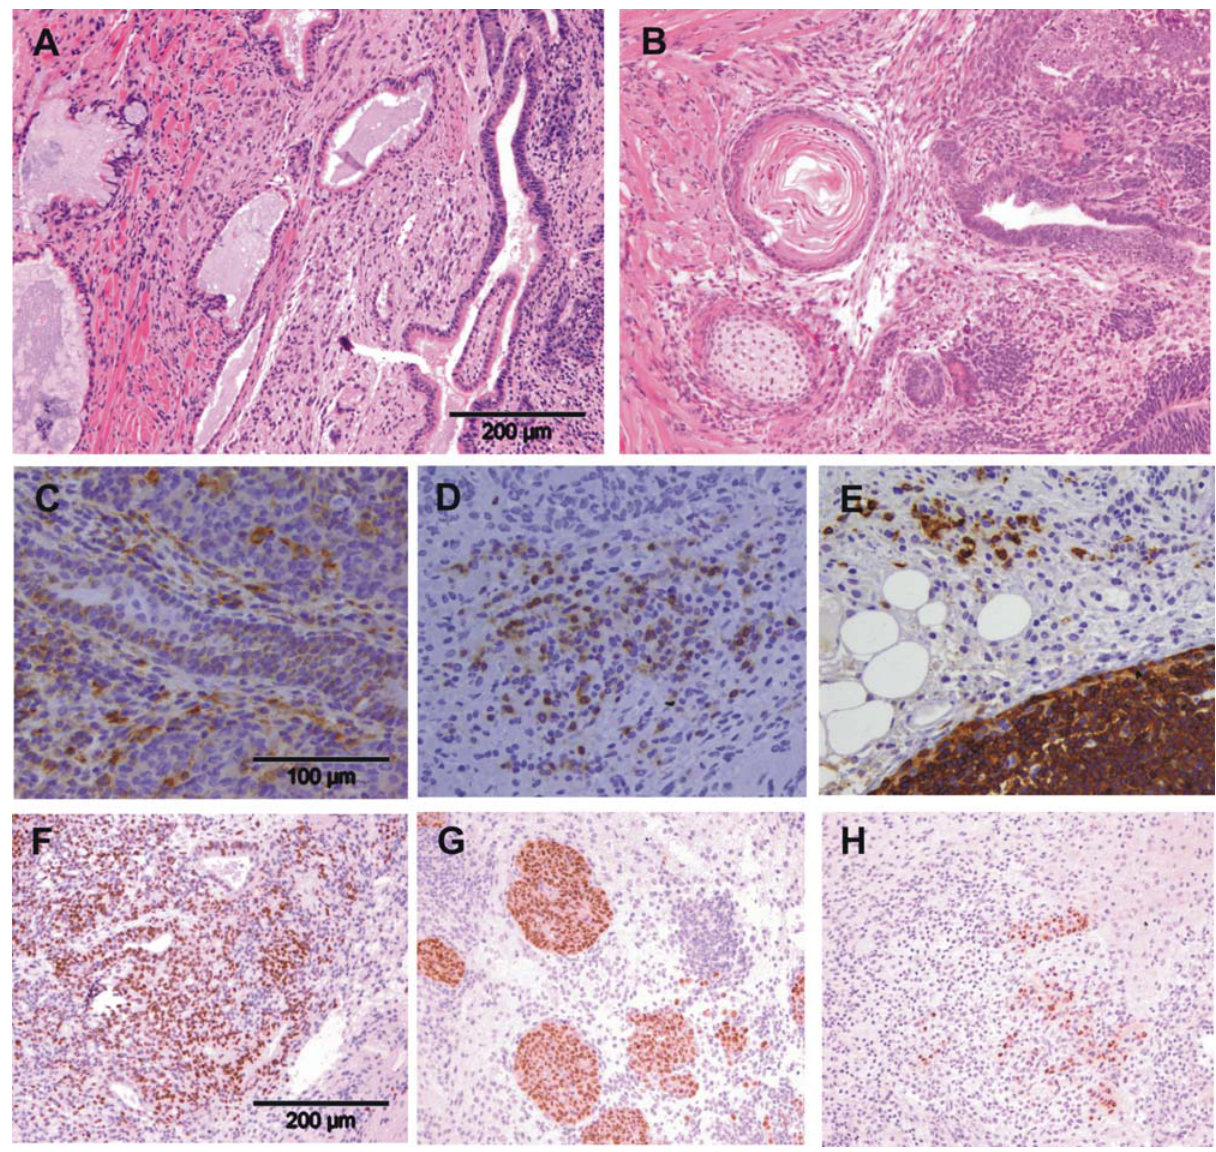
Figure 2. Histopathological analysis identifies tumors from ES and invitro differentiated cells as teratomas. Tumors grown in 129Sv mice after injection of ES cells (A) or after injection of in vitro differentiated cells (B) were HE stained. The tumors are teratomas which show